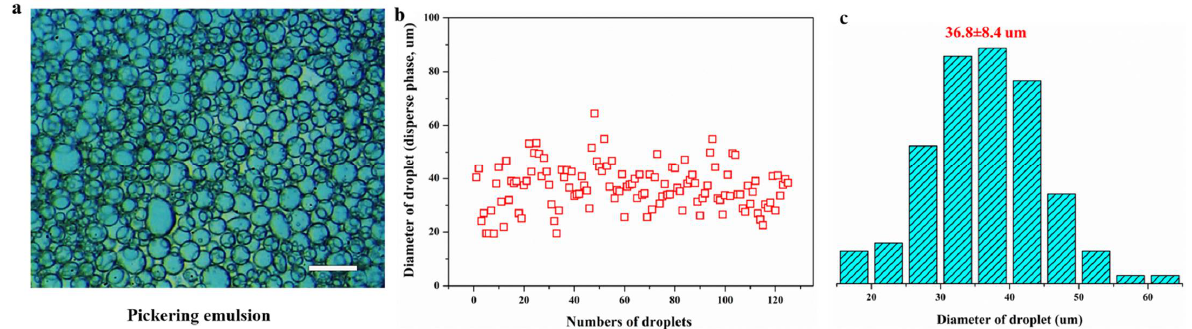
Figure 6. ( a ) Microscopic picture captured immediately after the formation of the stable Pickering emulsion (the measure- ment scale was 100 μm), ( b ) the calculated diameter of droplets (dispersed phase), and ( c ) its size distribution.